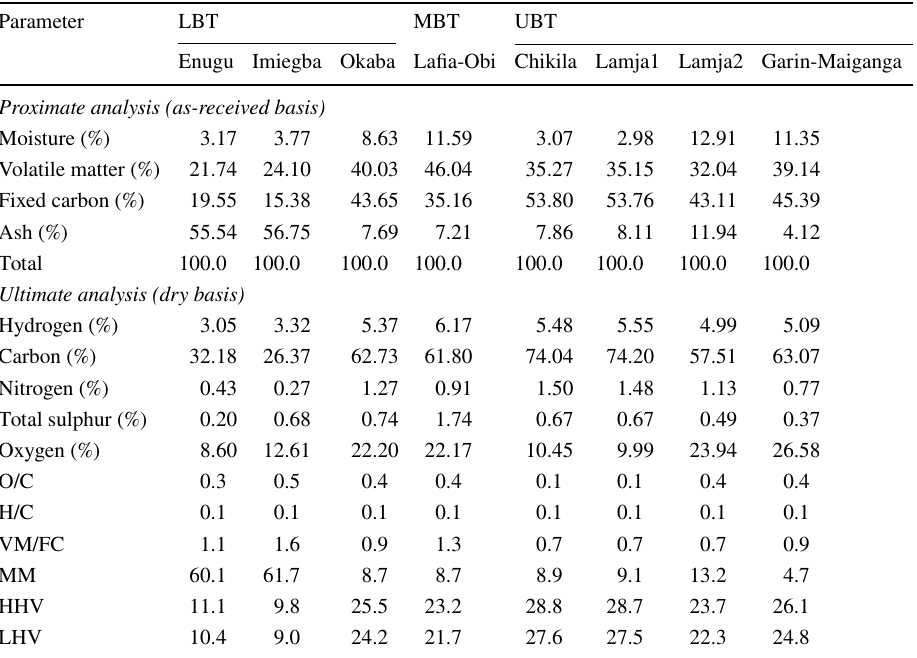
Table 1 Proximate and ultimate analyses of Cretaceous coals from Benue Trough